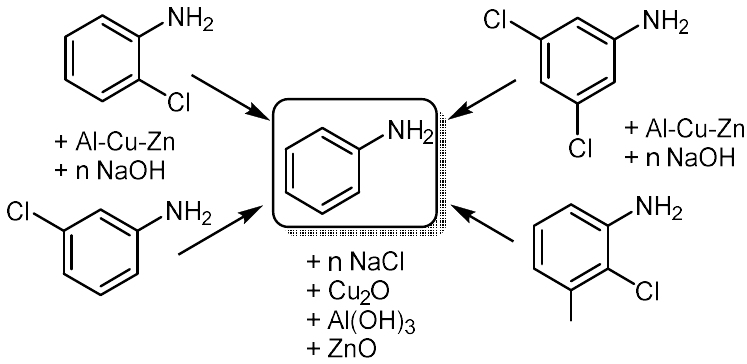
Figure 1. The reaction scheme of m and o -chloroanilines HDC using the Devarda’s Al-Cu-Zn alloy.